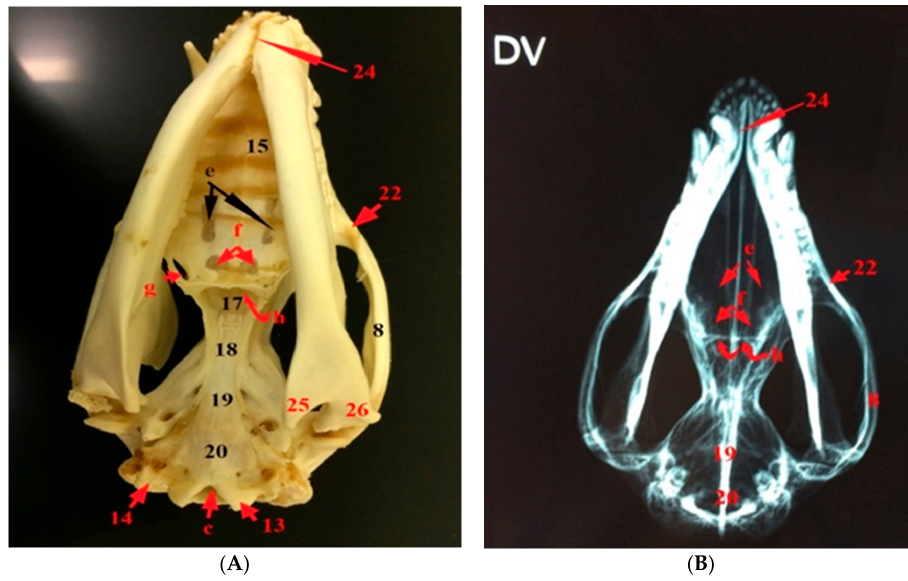
Figure. 3. Images showing the gross anatomy ( A ) and radiography ( B ) of the dorsoventral view of the skull and mandible of the common opossum. 8. zygomatic process of squamosal bone; 13. occipital condyle; 14. jugular process; 15. palatine process of maxilla; 17. vomer bone; 18. presphenoid bone; 19. basisphenoid bone; 20. basioccipital bone; 22. zygomatic process of maxilla; 24. mandibular symphysis; 25. angular process; 26. condylar process c. foramen magnum; e. maxillopalatine fenestra; f. palatine fenestra; g. caudal palatine foramen; and, h.